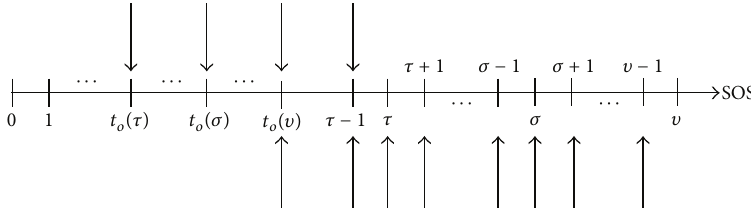
Figure 7: The SOSA of the environment at which genes are